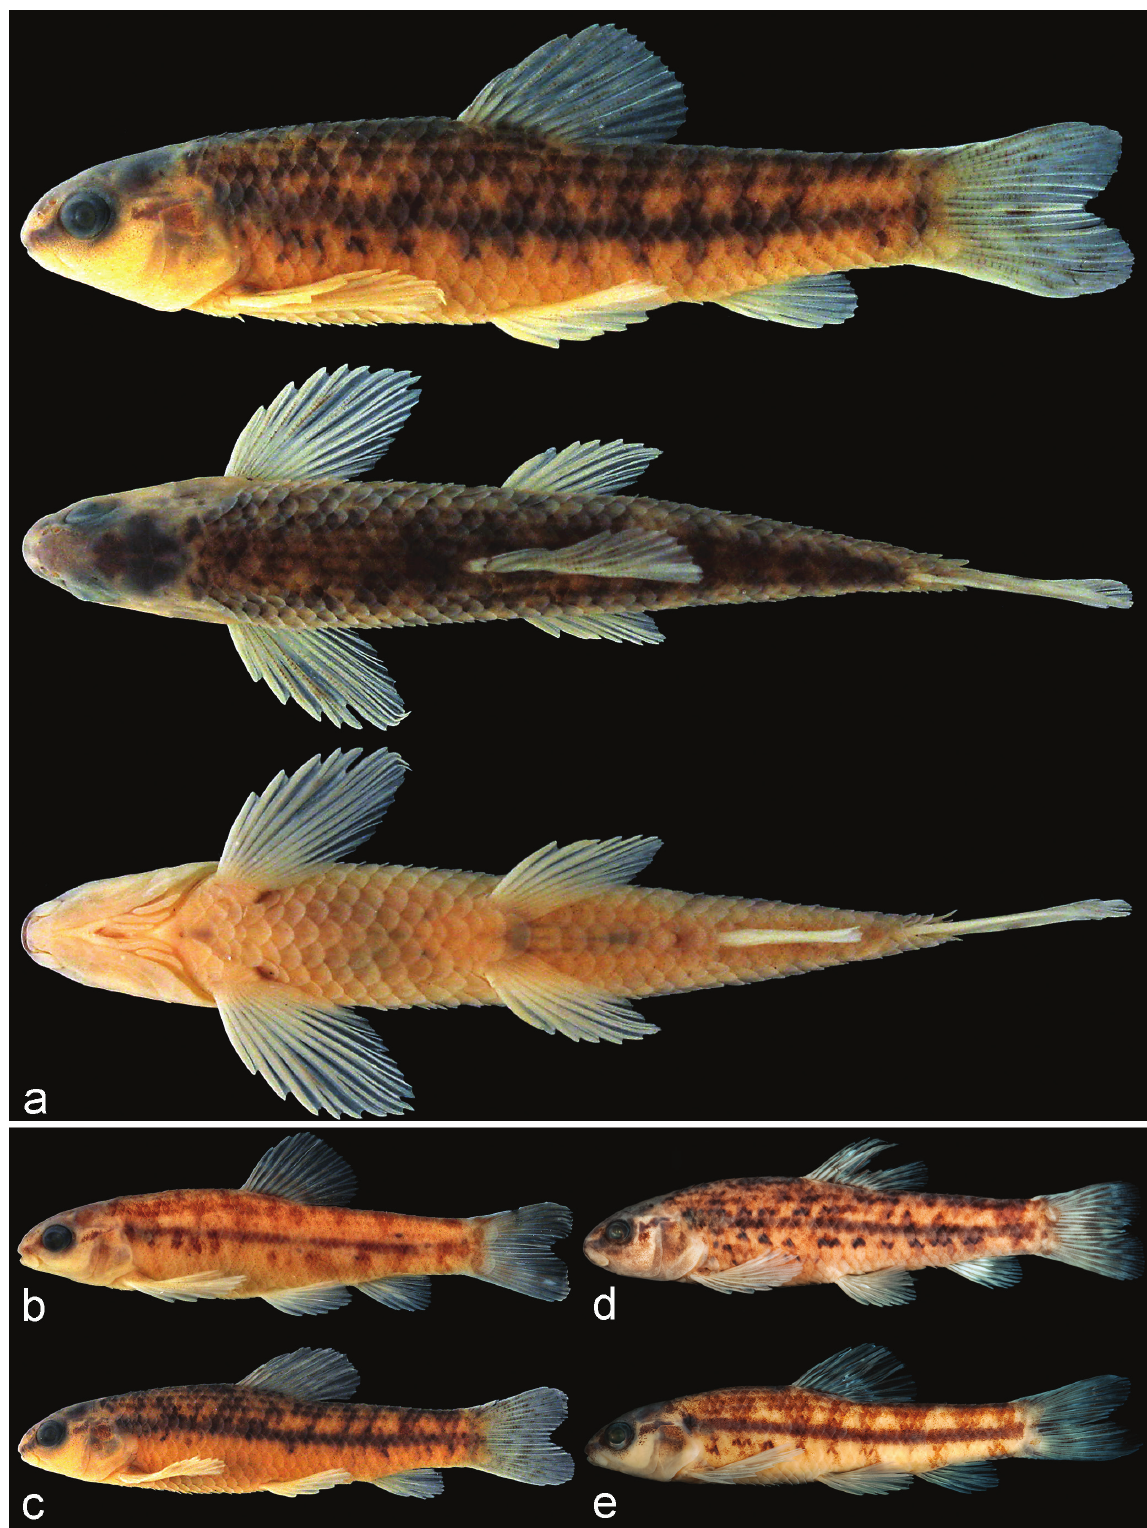
Fig. 1. Characidium travassosi , new species: (a) MZUSP 85940, 33.8 mm SL, holotype in lateral, dorsal and ventral views; stream tributary of rio Jordão, rio Iguaçu basin; (b) MZUSP 85938, 32.0 mm SL, and (c) MZUSP 85938, 32.9 mm SL, paratypes, rio Quadrado, rio Iguaçu basin; (d) MZUSP 68142, 56.3 mm SL, paratype, rio Taquari, tributary of rio Capivari, rio Ribeira de Iguape basin, (e) MZUSP 68144, 40.3 mm SL, paratype, rio Taquari tributary of rio Capivari, rio Ribeira de Iguape